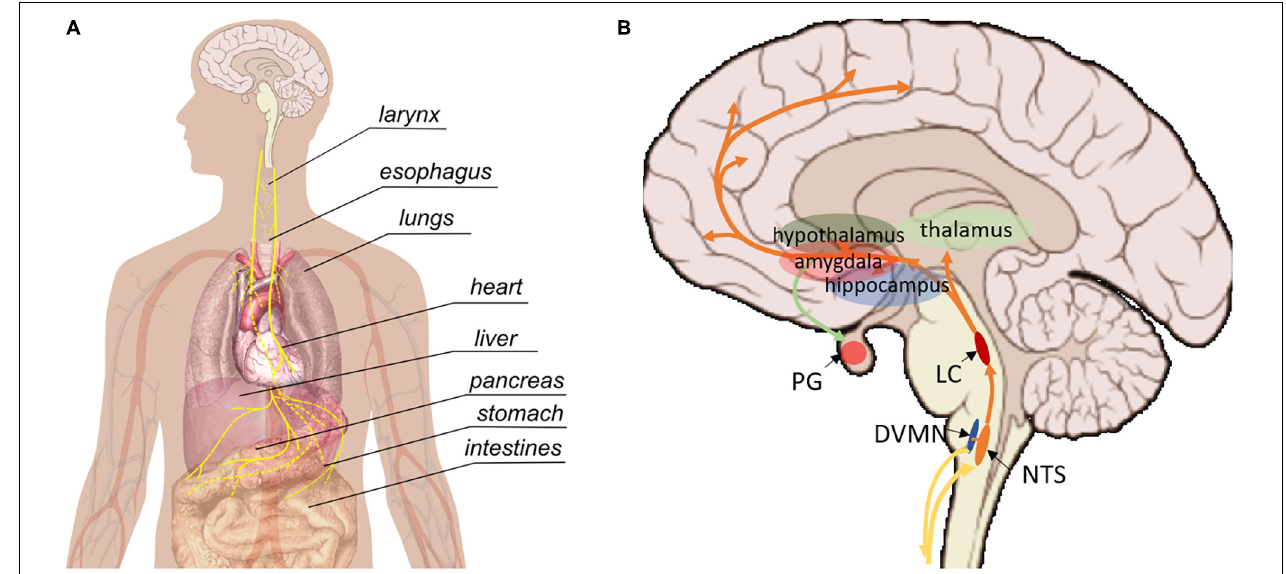
FIGURE 1 | Pathways involved in vagus nerve stimulation. (A) Peripherally, the vagus nerve provides afferent and efferent innervation of the majority of visceral organs. (B) Central regions that are impacted by vagus nerve stimulation. NTS, nucleus tractus solitarii; DVMN, dorsal motor nucleus of the VN; LC, locus coeruleus, PG, pituitary